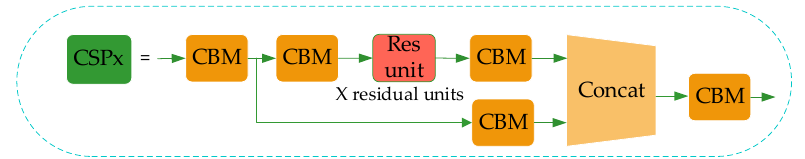
Figure 3. CSPDarkNet53 module structure.